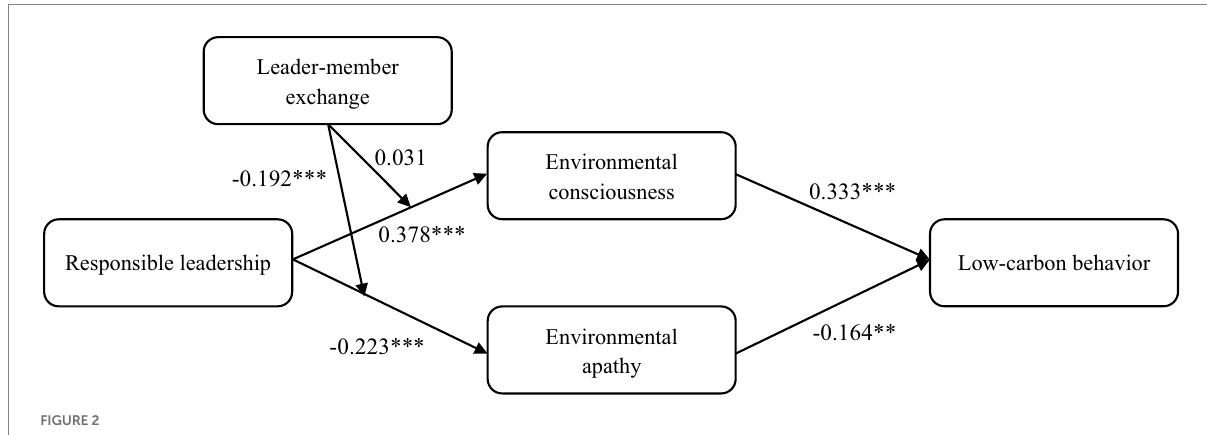
Hypotheses 1c and 2c were supported. In addition, Figure 2 presents the final model with the empirical results.